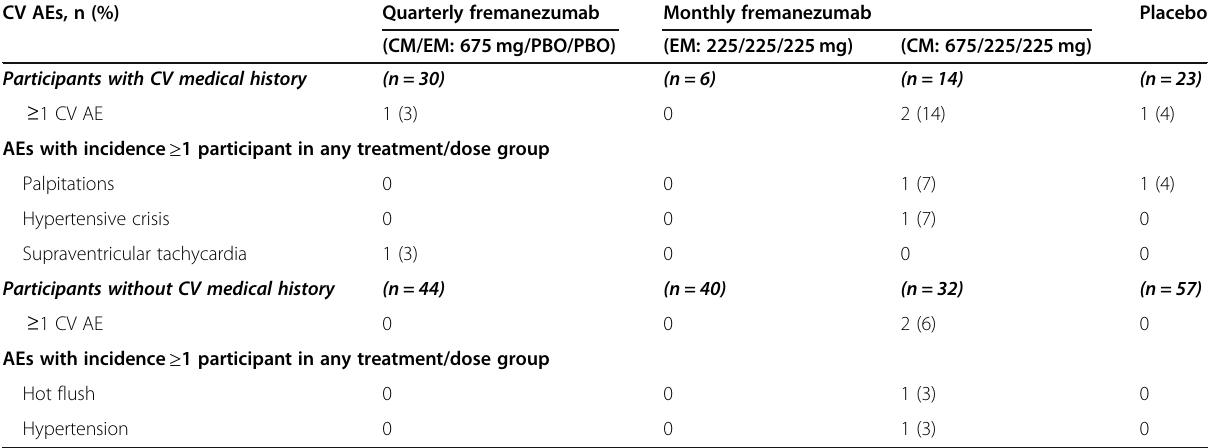
Table 3 Cardiovascular adverse events in participants ≥ 60 years of age with a cardiovascular medical history CV AEs, n (%)